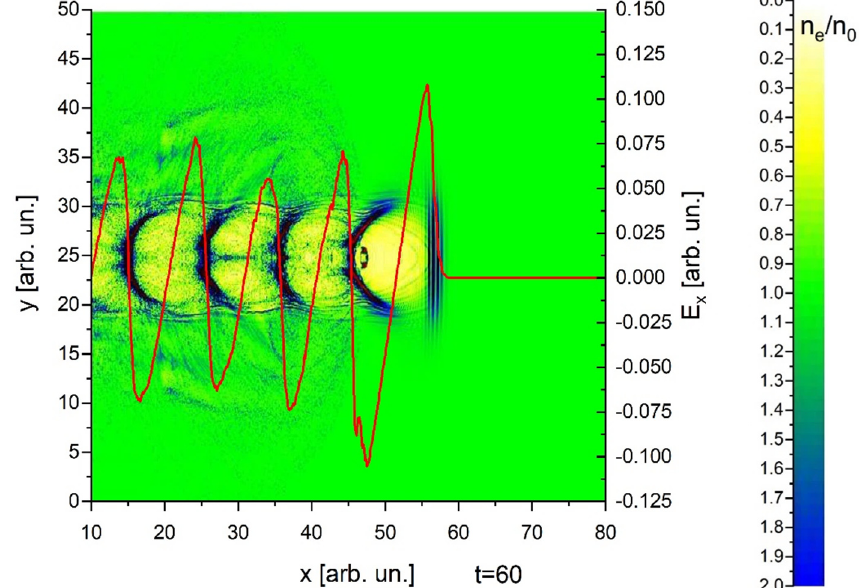
Figure 1. Excitation of a wakefield by a laser pulse in homogeneous plasma t = 60 T 0 . The self-injected bunch is close to the area of maximum accelerating gradient. Separate areas in which the ratio of electron densities reaches a value of 9 are highlighted in red. Plasma electron density and longitudinal accelerating field distributions. x, y are normalized to λ , E x is normalized to E 0 = m e c ω ℓ /2 π e .